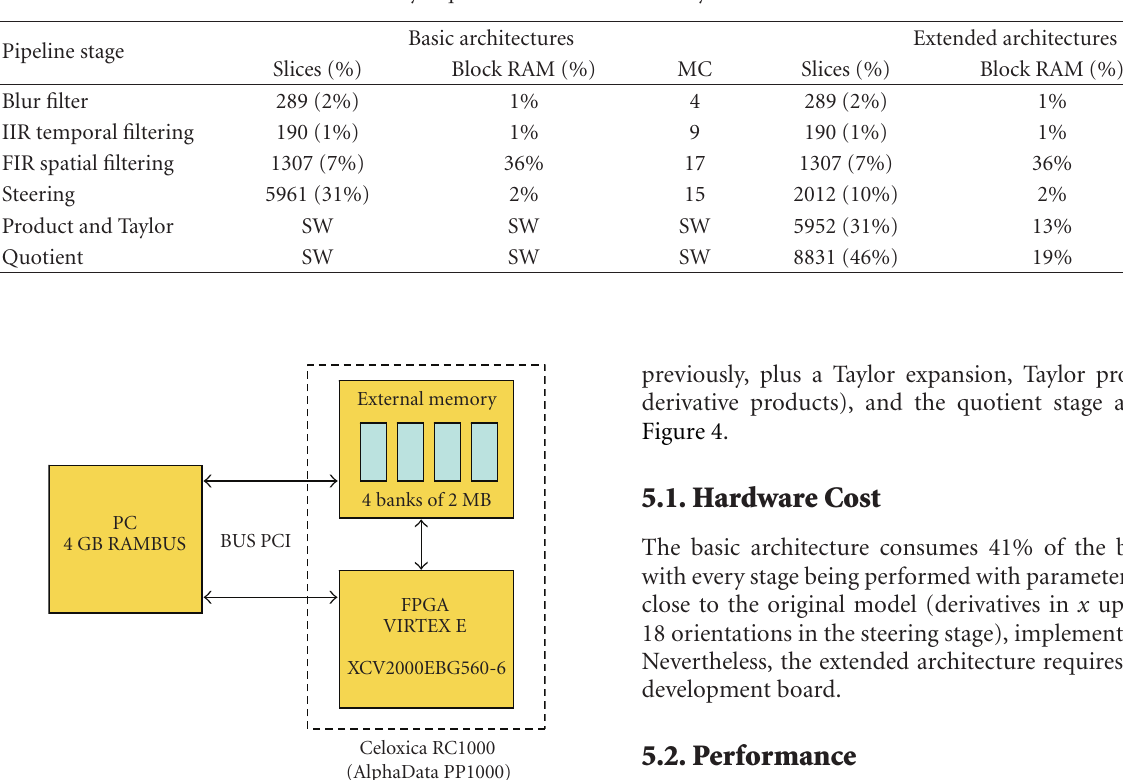
Table 3: Slices and memory requirements and number of cycles for basic and extended architectures.